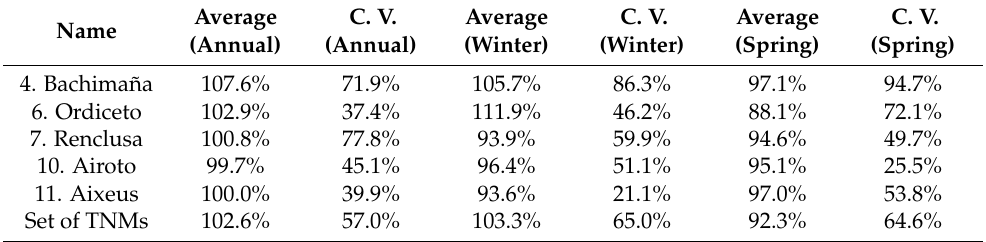
Table 5. SDEN statistics comparison between automatic data for TNM sites in the same location as manual samples.